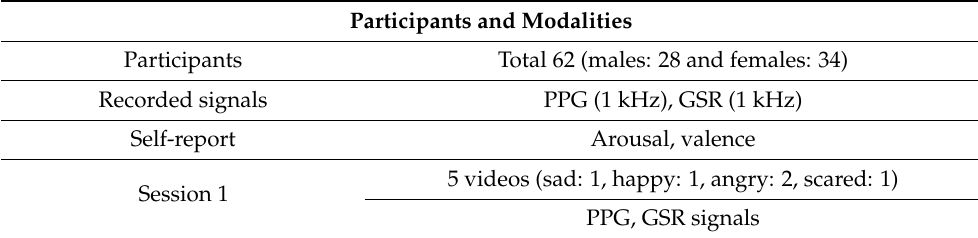
Table 1. Bio-signal data summary used in session 1 in the MERTI-Apps dataset. Figure 7. Proposed 1D CNN model for driver’s situation and emotion recognition.